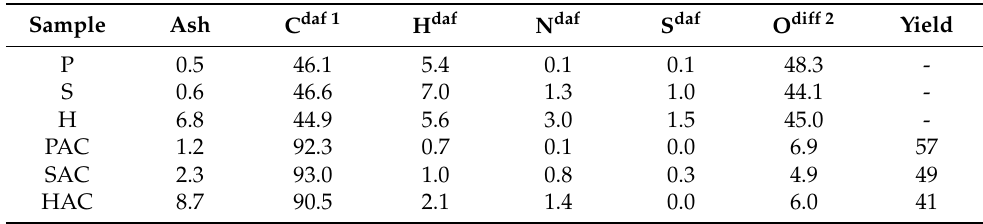
Table 1. Elemental composition of the precursors and activated biocarbons prepared as well as the yield of the chemical activation process (wt.%).